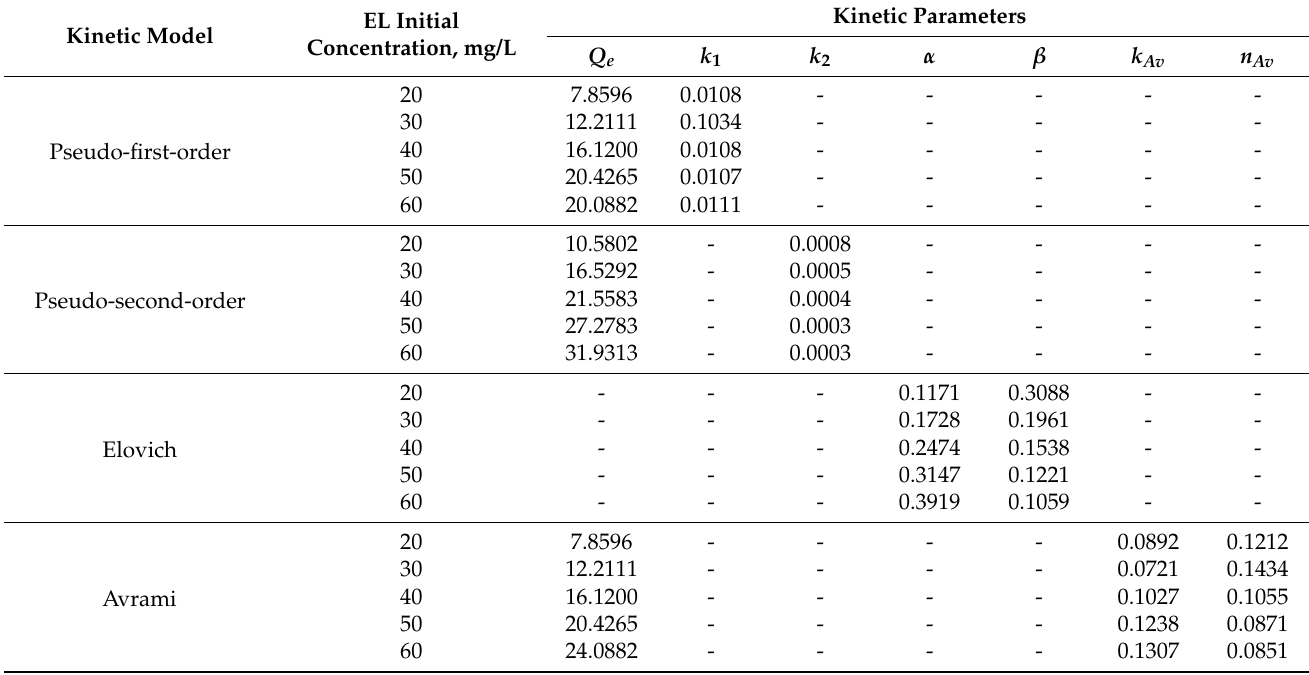
Table 5. Kinetic parameters of the biosorption process conducted on SPRBA 5%